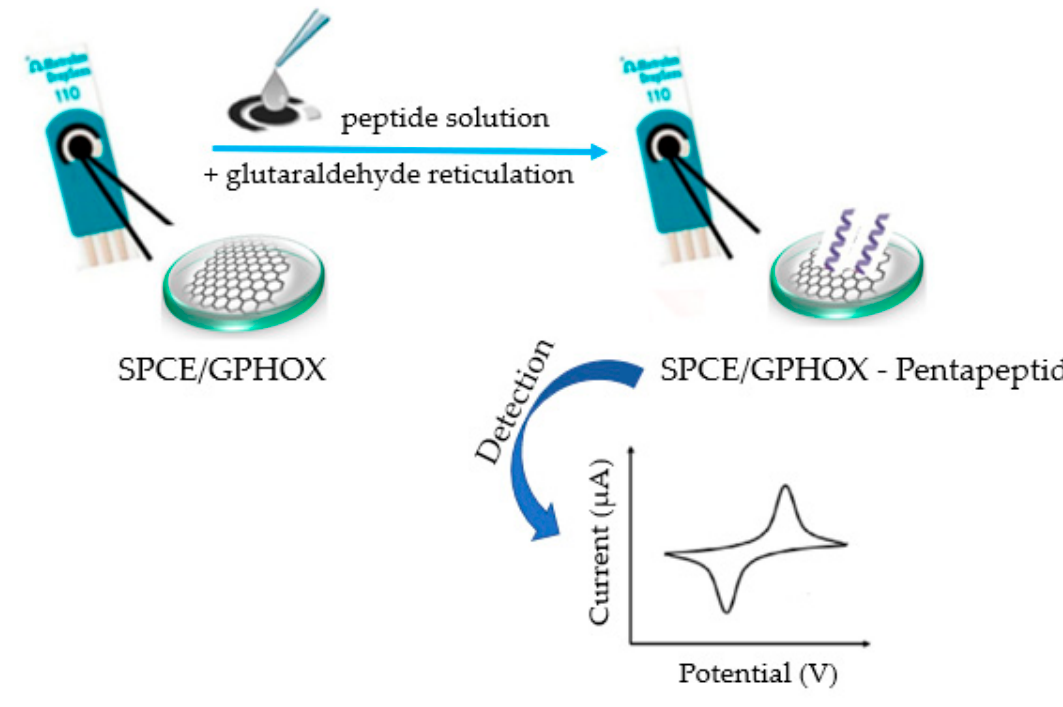
Figure 14. Preparation process of SPCE/GPHOX-Pentapeptide sensor.